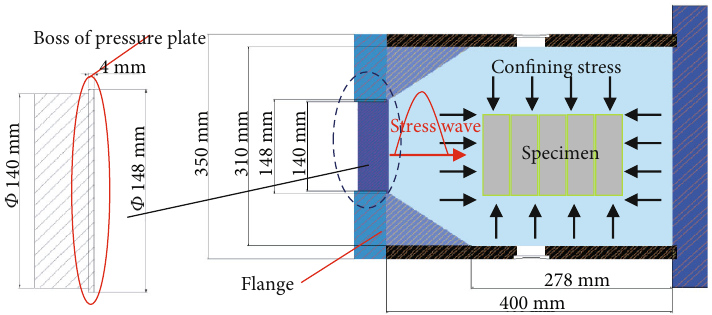
Figure 6: Schematic of con fi ning stress and stress wave in the container.